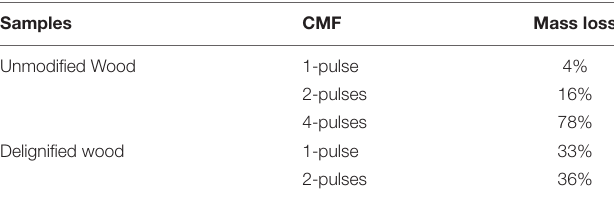
lignin. Mass loss for all samples averaged 29 ± 5% after 3 PAA treatment cycles. No shaving samples were treated with